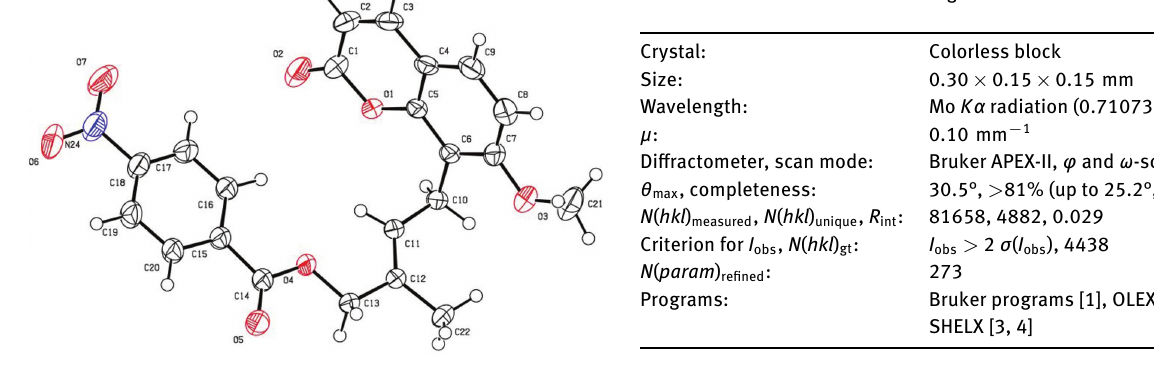
Table 2: Fractional atomic coordinates and isotropic or equivalent isotropic displacement parameters (Å 2